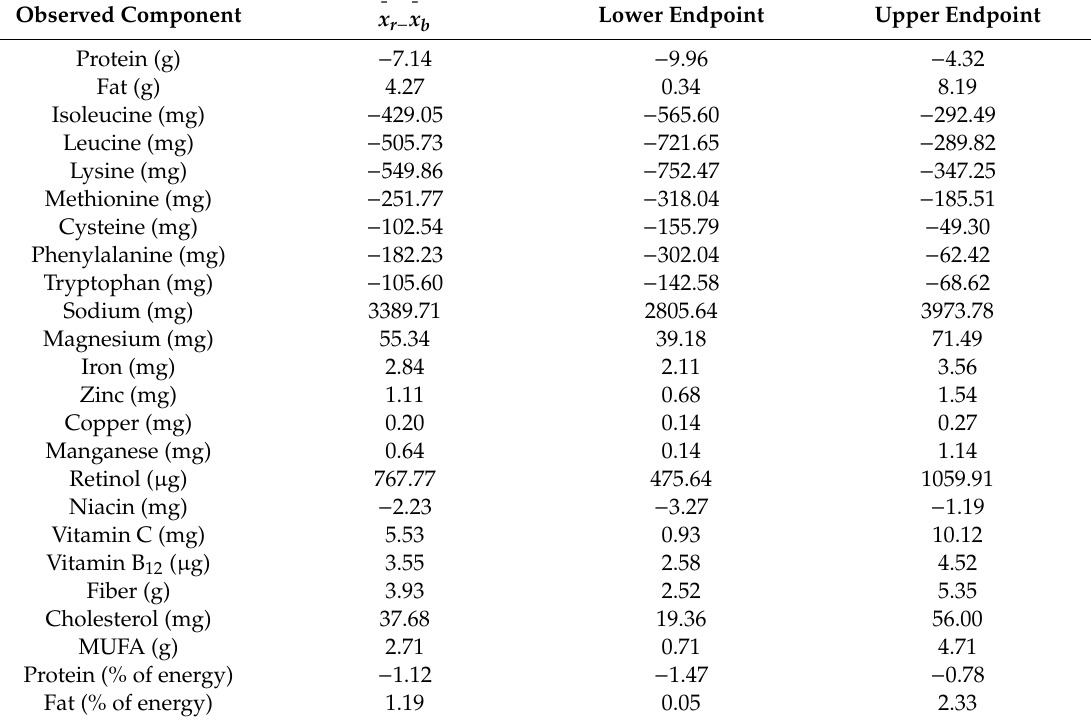
Table 4. Lower and upper endpoints of a 95% confidence interval for the di ff erence between mean values of regular and bland diet ( x r —mean value for regular diet, x b —mean value for bland